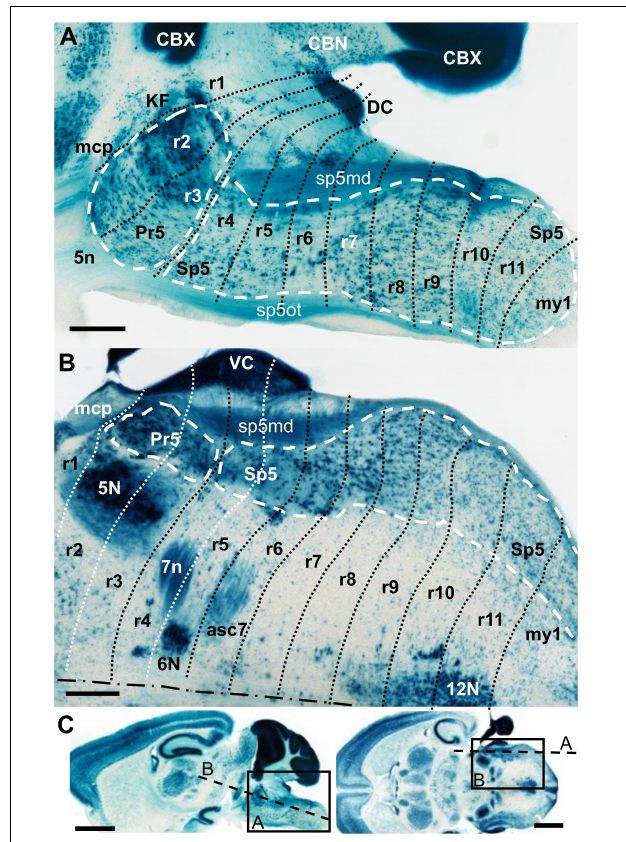
FIGURE 1 | AZIN2-LacZ expression in the adult hindbrain. (A,B) Respective details of parasagittal and horizontal sections. In each of them the rostral end is to the left. The black or white dotted lines indicate interrhombomeric boundaries. The white dashed lines delimit the principal sensory (Pr5) and the spinal trigeminal nucleus (Sp5). The dot-dash line in B indicates the midline. (C) Images of the original full sections. The rectangles delimit the respective positions of A and B images. The dashed lines indicate the respective approximate positions of their sectioning planes. 5n, trigeminal nerve root; 5N, trigeminal motor nucleus; 6N, abducens motor nucleus; 7n, facial nerve; 12N, hypoglossal motor nucleus; asc7, facial ascending fibers; CBN, cerebellar nuclei; CBX, cerebellar cortex; DC, dorsal cochlear nuclei; KF, Kölliker-Fuse nucleus; mcp, middle cerebellar peduncle; r, rhombomere(s); sp5md, mandibular fibers of the trigeminal tract; sp5ot, ophthalmic fibers of the trigeminal tract; VC, ventral cochlear nuclei. (A,B) Scale bars = 500 µ m, (C) scale bars = 2,000 µ